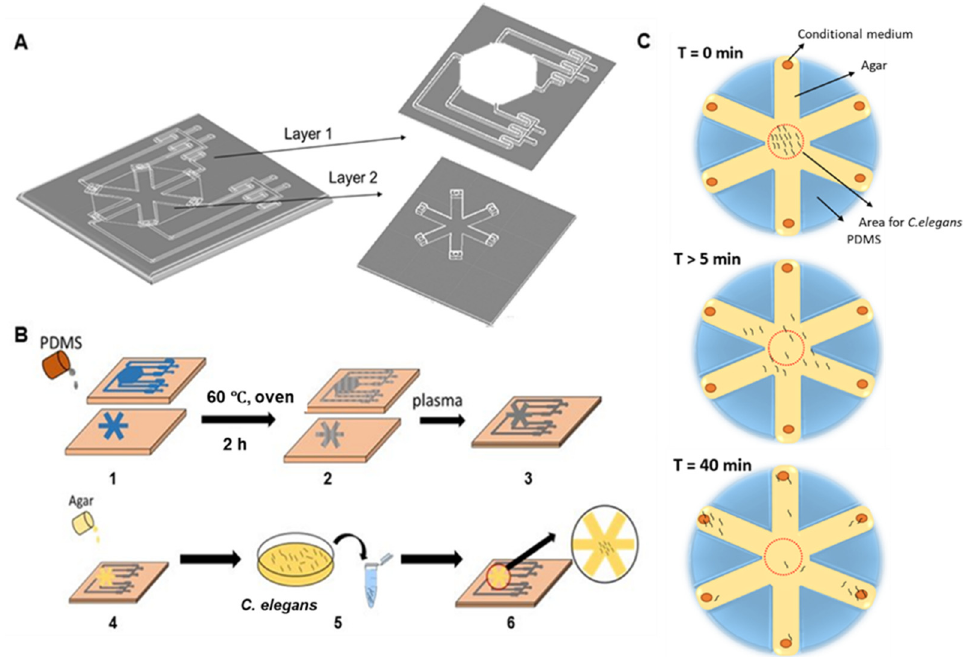
Figure 1. Schematics of the worm-based (WB) biosensor for the detection of metastatic disease. ( A ) Overview of the assay design for the WB biosensor. Worms were placed into chambers connected to inlets for sample loading. ( B ) The workflow of device fabrication and biosensor operations. (1) PDMS was poured into the device mold and cured at 60 ℃ for 2 h. (2) Resultant device layers. (3) Device layers were bonded by standard plasma treatment. (4) 1.5% agar solution was coated on the channels. (5) C. elegans were harvested in a 1.5 mL tube. (6) C. elegans were added to the WB biosensor. Imaging was done in situ with phase-contrast microscopy. ( C ) Experimental procedures with the WB biosensor. PDMS = polydimethylsiloxane; T = time.